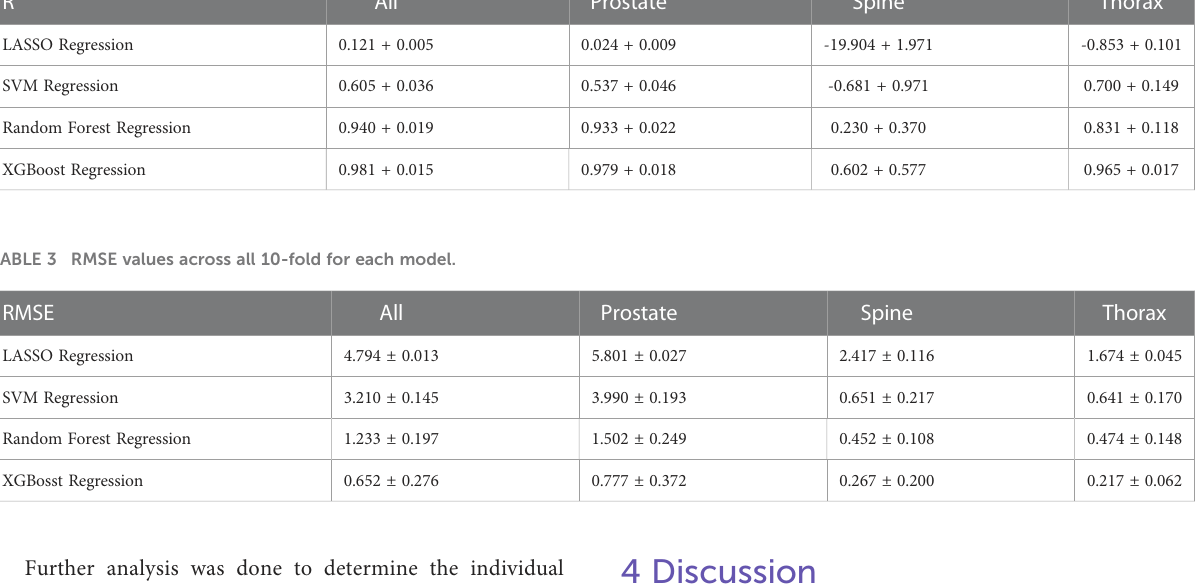
TABLE 2 R 2 values across all 10-fold for each model. R